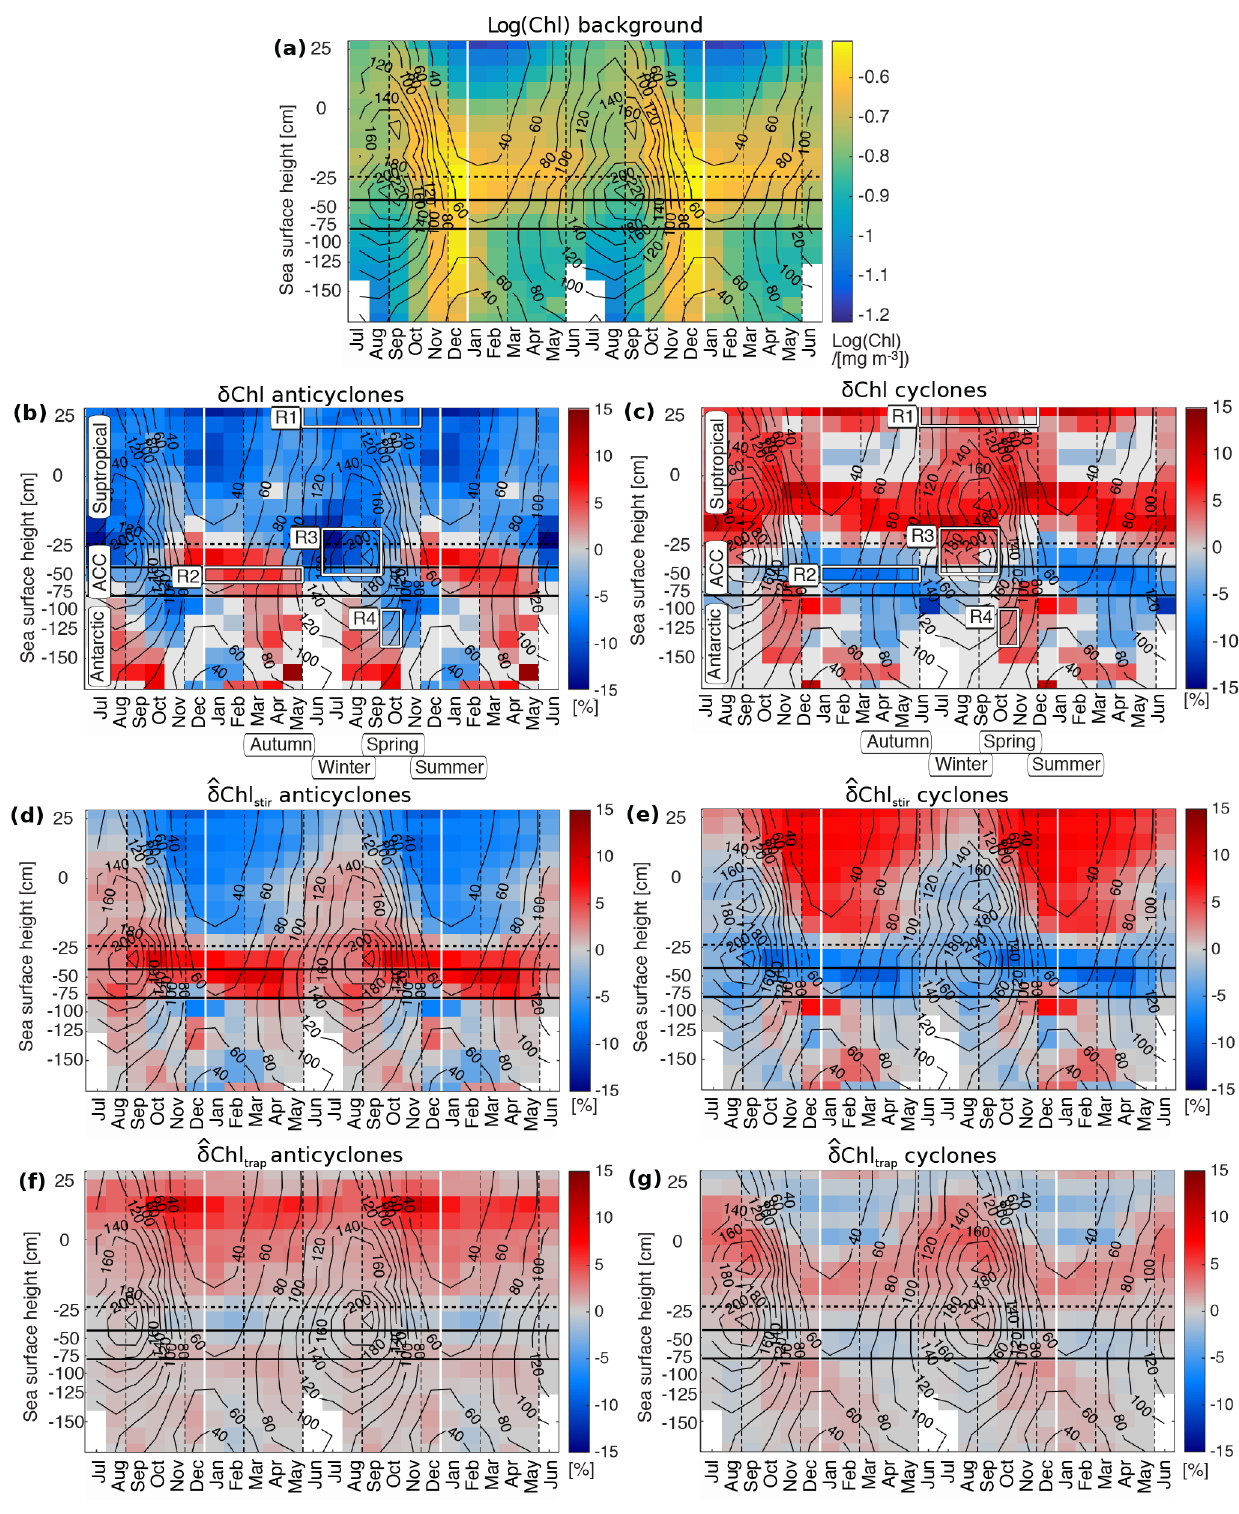
Figure 4. Seasonality of chlorophyll anomalies ( δ Chl) associated with eddies, and potential of eddies to cause δ Chl through lateral advection, i.e., ˆ δ Chl stir for stirring and ˆ δ Chl trap for trapping. (a) Base 10 logarithm of monthly climatological Chl for reference; (b, c) δ Chl related to anticyclones and cyclones, respectively; (d, e) advective potential (Sect. 2.3) due to stirring by anticyclones and cyclones, respectively; (f, g) , advective potentials due to trapping by anticyclones and cyclones, respectively. In panels (a) – (c) , Chl and δ Chl are the mean of all eddies lasting at least 3 weeks binned in monthly sea surface height (SSH) bins so that boxes roughly cover equal areas; in panels (b, c) white boxes indicate regions R1 to R4 used for composite Figs. 5 and 6. In all subpanels, values that are not significant ( t test, p > 0 . 05 ) are colored in light gray, insufficient data (less than three data points) in white; solid black lines mark the ACC (approximate positions of the Subantarctic Front and Polar Front); the horizontal dashed black line denotes the − 20 cm SSH contour, the vertical dashed lines seasons; solid black contours show averaged mixed layer depths in meters; note that the seasonal cycle is shown repeatedly to highlight cyclic